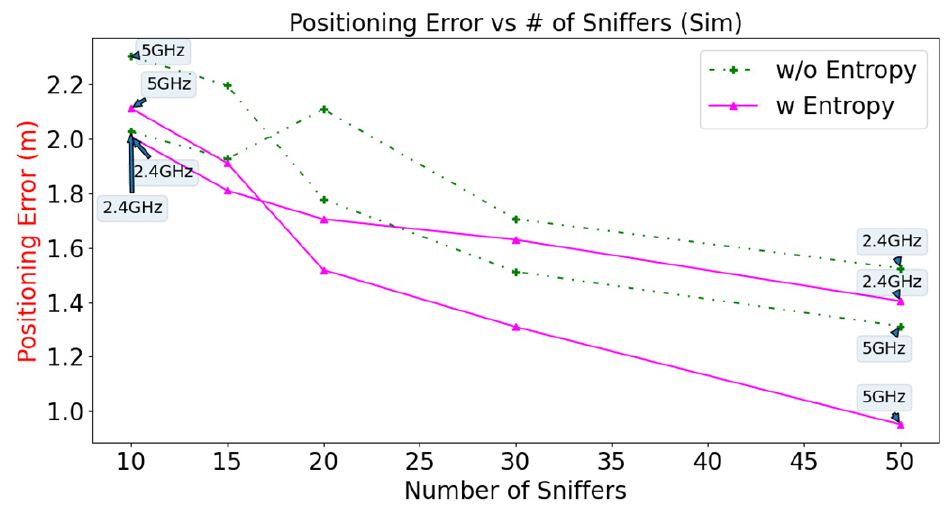
Figure 11. Positioning error versus number of Sniffers for different configurations of simulated data (10, 15, 20, 30, 50 Sniffers).